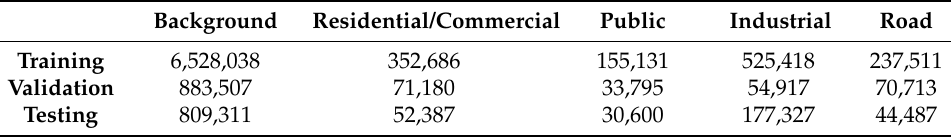
Table 4. Class sizes in each sub-dataset measured as number of pixels in the labeled